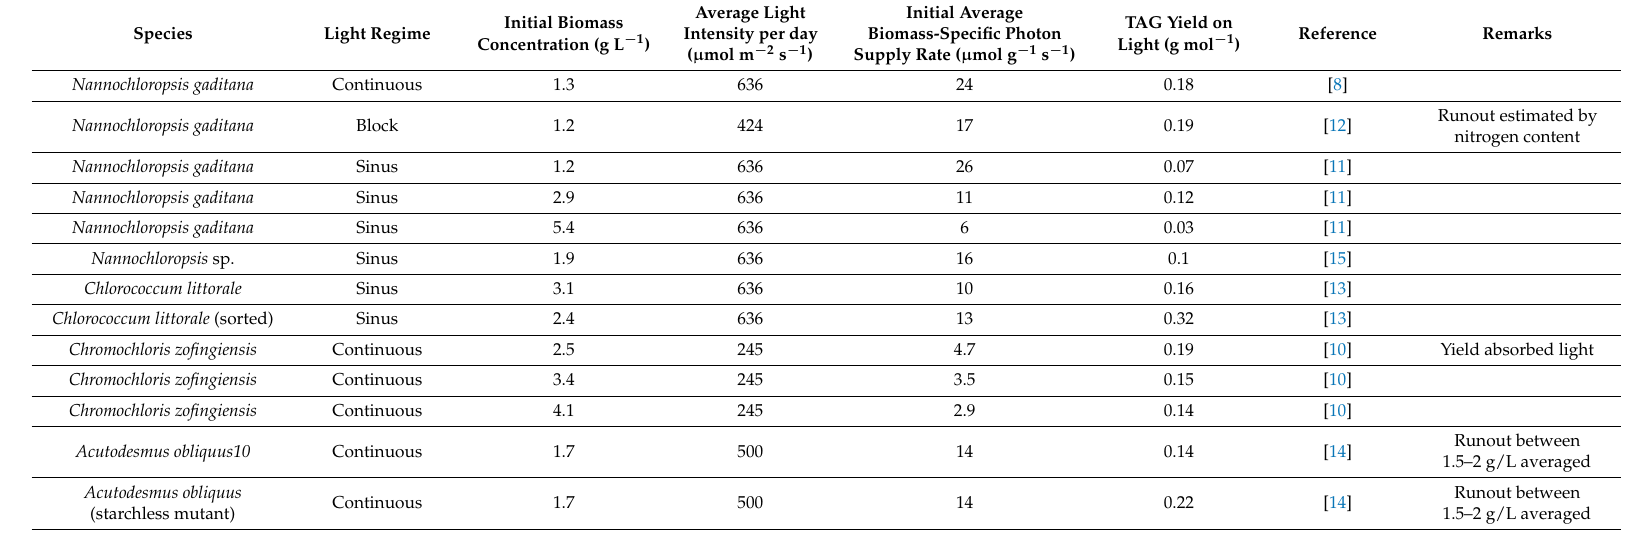
Table A1. Comparison TAG yield on light of different microalgae species using different biomass-specific photon supply rates and their respective